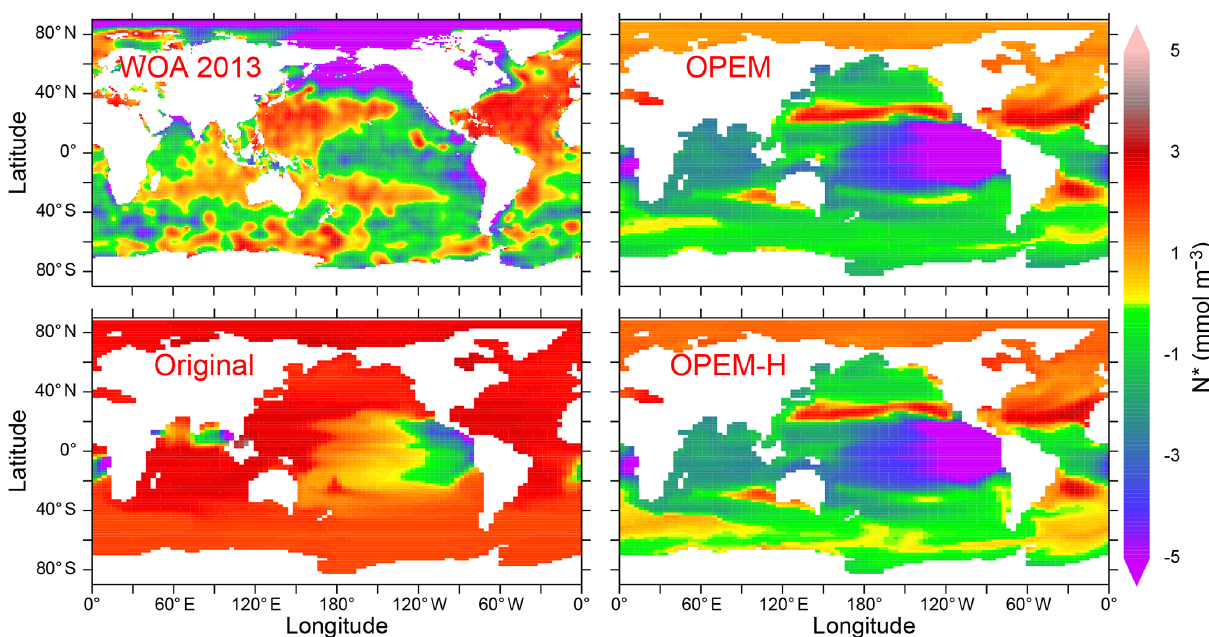
Figure 5. Annually averaged distribution of N* in the upper 50m in the WOA 2013 climatology and in the original, OPEM, and OPEM-H UVic simulations. Global averages for the upper 50m are − 0 . 4mmolm − 3 for the WOA 2013 and 1 . 8, − 1 . 3, and − 1 . 1mmolm − 3 for the original, OPEM, and OPEM-H simulations, respectively.